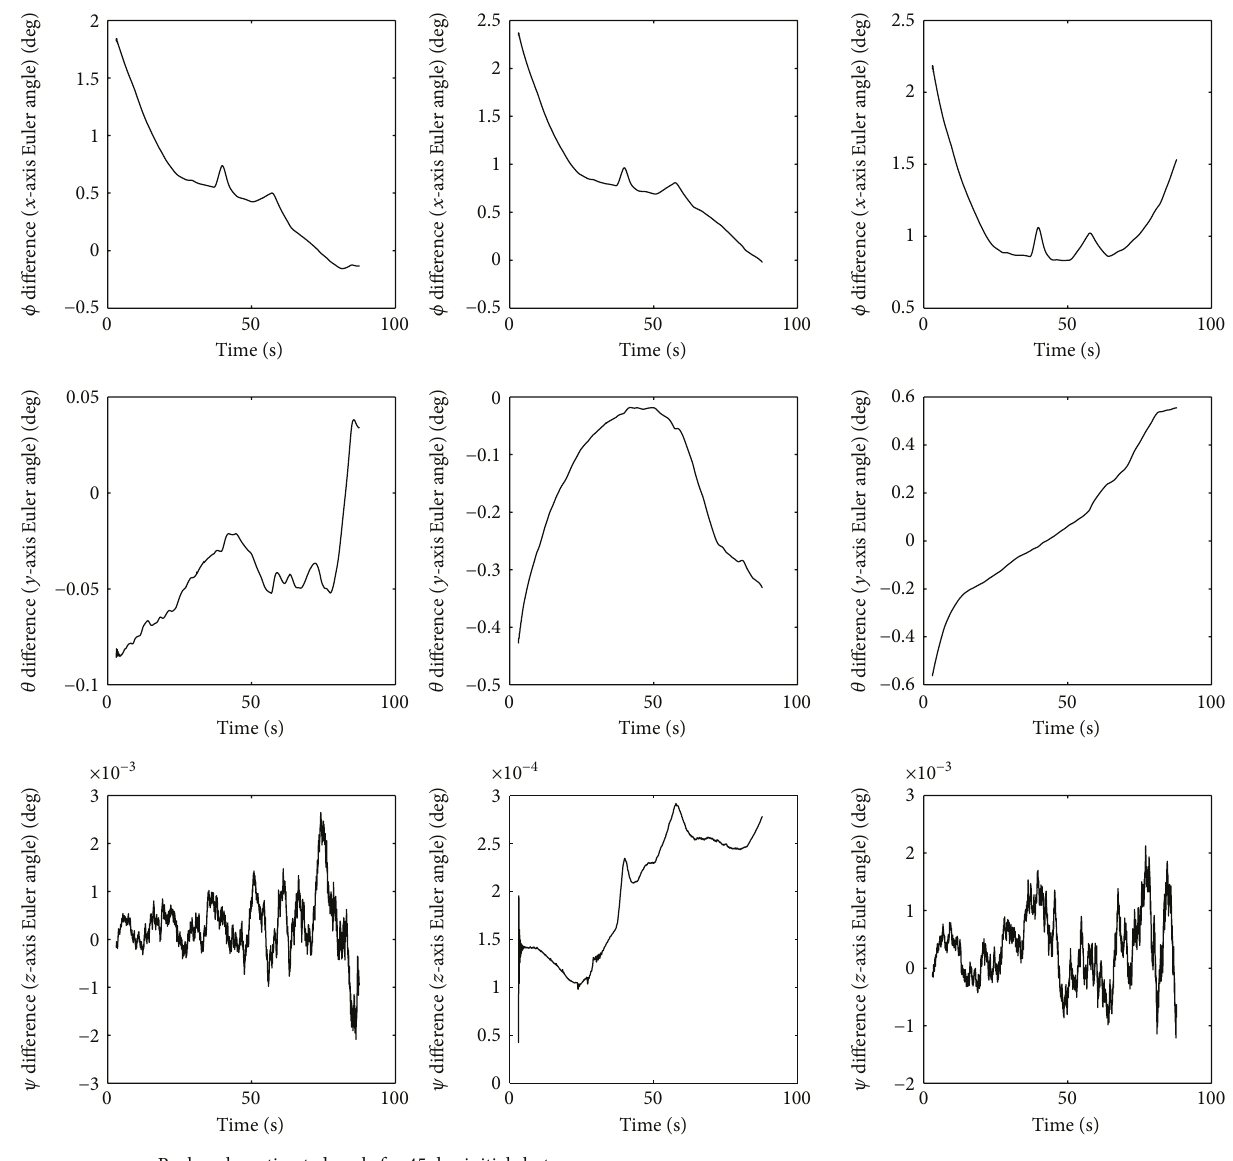
Figure 2: Comparison between estimated and real magnitudes for Euler angles for a shot angle of 45 deg and azimuths of 0 ° (left), 45 ° (center), and 90 °